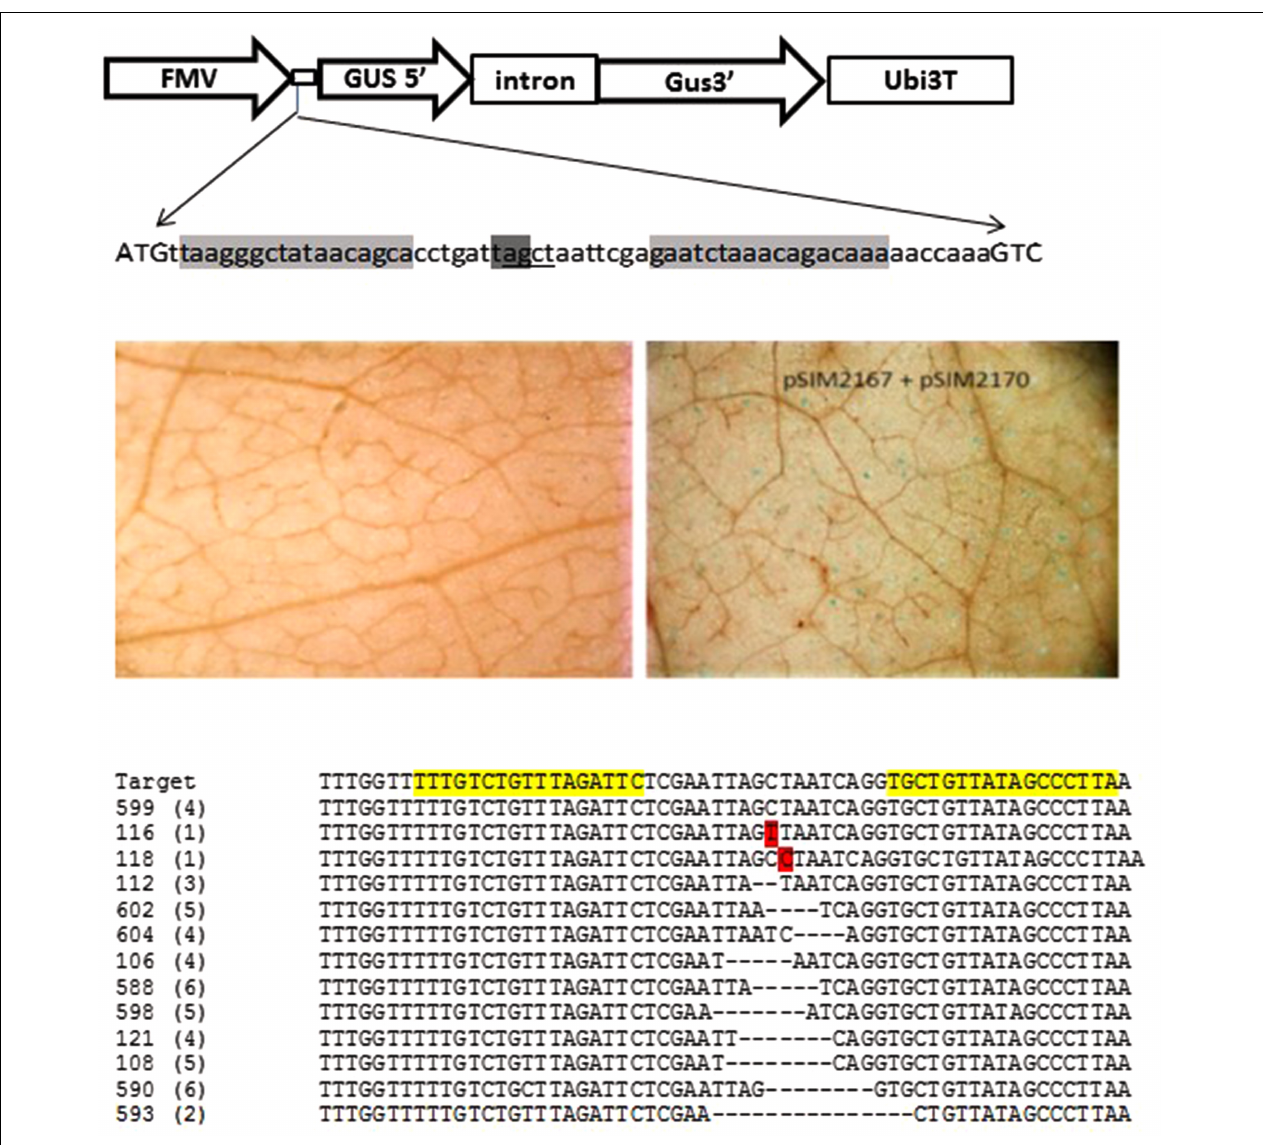
FIGURE 3 | Verification of designed TALENs in N. benthamiana infiltration. (Top panel) Target vector pSIM2167 of TALENs for N. benthamiana infiltration. A 60 bp DNA sequence from StUbi7 5 (cid:48) intron was inserted between the first and second amino acid codons of the GUS gene. There is an in frame stop codon (dark gray highlighted) in the spacer region between the two recognition sites (light gray highlighted) which will abolish the GUS protein translation. TALEN-mediated DNA cleavage and subsequent NHEJ based repairing will destroy the stop codon and translation of the GUS will be in frame and restore GUS activity. An AluI restriction enzyme site (underlined) was also included in the spacer to facilitate detection of TALEN-mediated indels. (Middle and bottom panels): The functionality of designed TALEN in transient assay. Target construct was Agro -infiltrated into N. benthamiana leaves alone or together with the TALEN construct. Forty-eight hours after infiltration, leaf tissue at the infiltrated site was collected and stained with GUS staining solution and de-stained with ethanol for microscopic examination. DNA was isolated from co-infiltrated tissue, digested with AluI , PCR amplified, cloned and sequenced. (Middle left panel): Target construct pSIM2167 alone. (Middle right panel): Target construct pSIM2167 co-infiltrated with TALEN construct pSIM2170. (Bottom panel): Sequences of target region with various modifications. The number in the parenthesis represents how many times the modification occurred in the 50 clones sequenced. The numbers on the left are identifiers of the respective